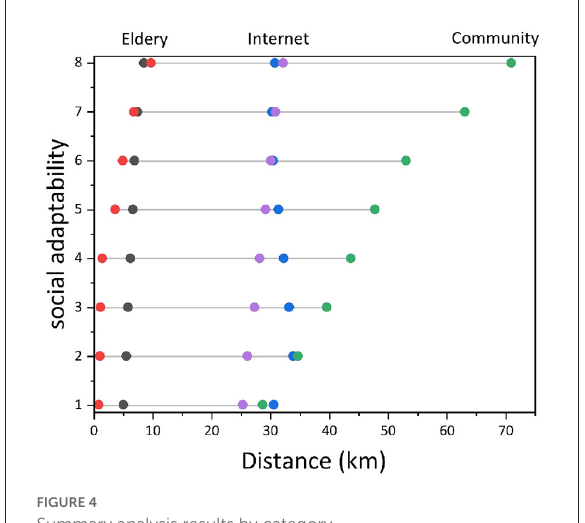
FIGURE4 Summary analysis results by